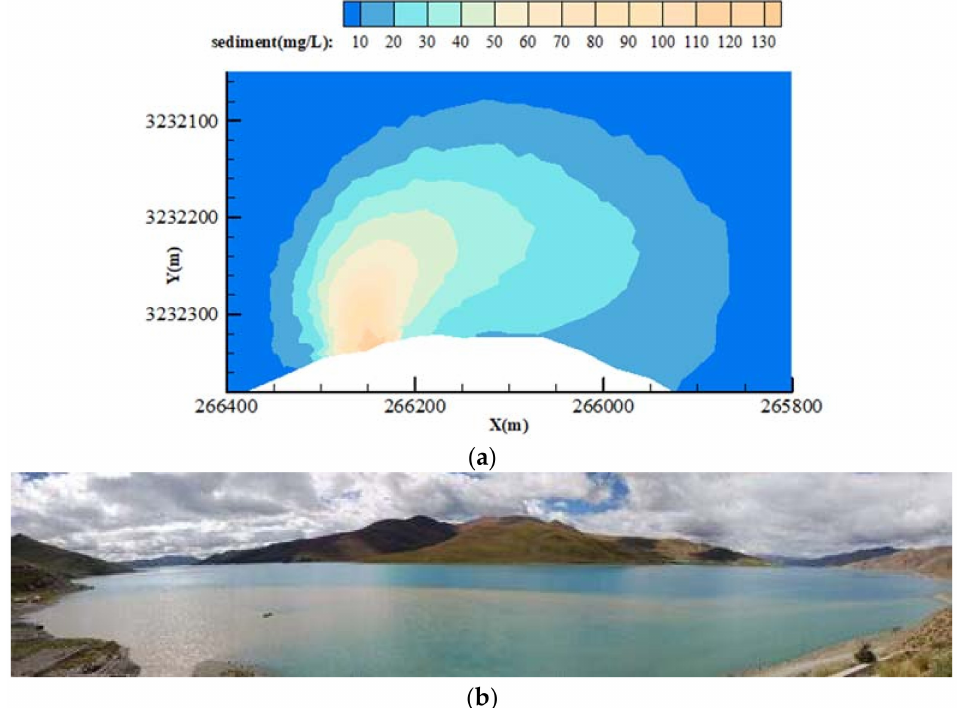
Figure 11. Water landscape color prediction map and real map of Alpine lakes. The sediment inlet is located in the area of Tibet and Gongga. ( a ) is a picture of prediction of water landscape color in a high mountain lake with sediment-laden discharge. ( b ) is a real picture of the water landscape color of water flowing into a high mountain